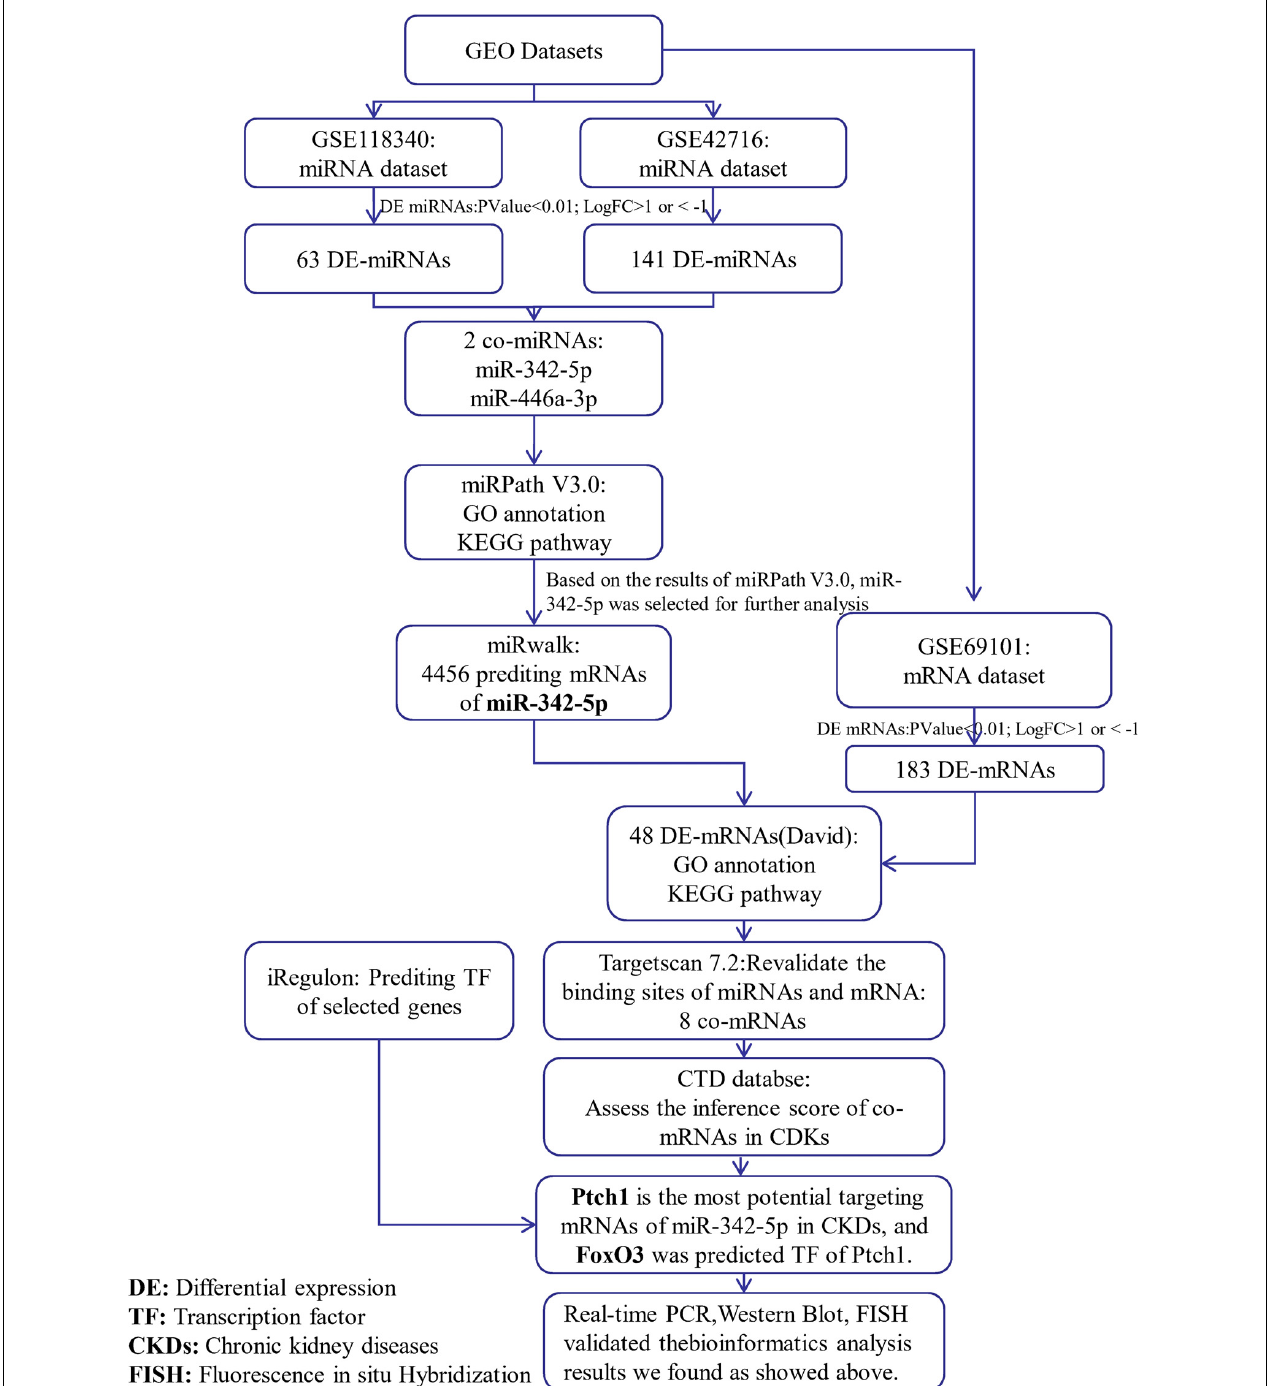
FIGURE 1 | Simple flow chart of bioinformatics analysis and experimental design.